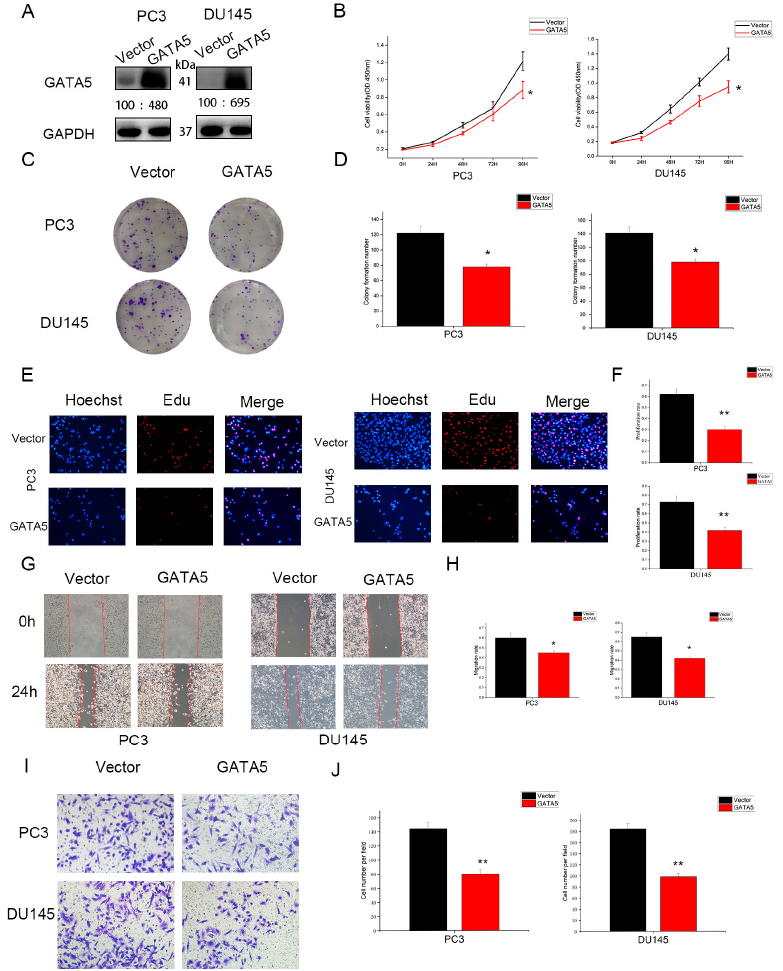
Figure 2. GATA5 overexpression inhibits the proliferation, migration, as well as invasion of PCa cells in vitro. ( A ) The effect of GATA5 overexpression was verified by Western blotting analysis. ( B ) Compared with the pc-vector group, the growth rate in the pc-GATA5 group was lower. ( C , D ) Overexpression of GATA5 suppressed colony formation. ( E , F ) The EdU assay showed that GATA5 overexpression decreased cell proliferation. ( G , H ) The migration capability was assessed through the wound-healing assay. ( I , J ) The invasive property was evaluated using a Transwell invasion assay. Data are presented as mean ± SD of at least three experiments. * p < 0.05 and ** p < 0.01.